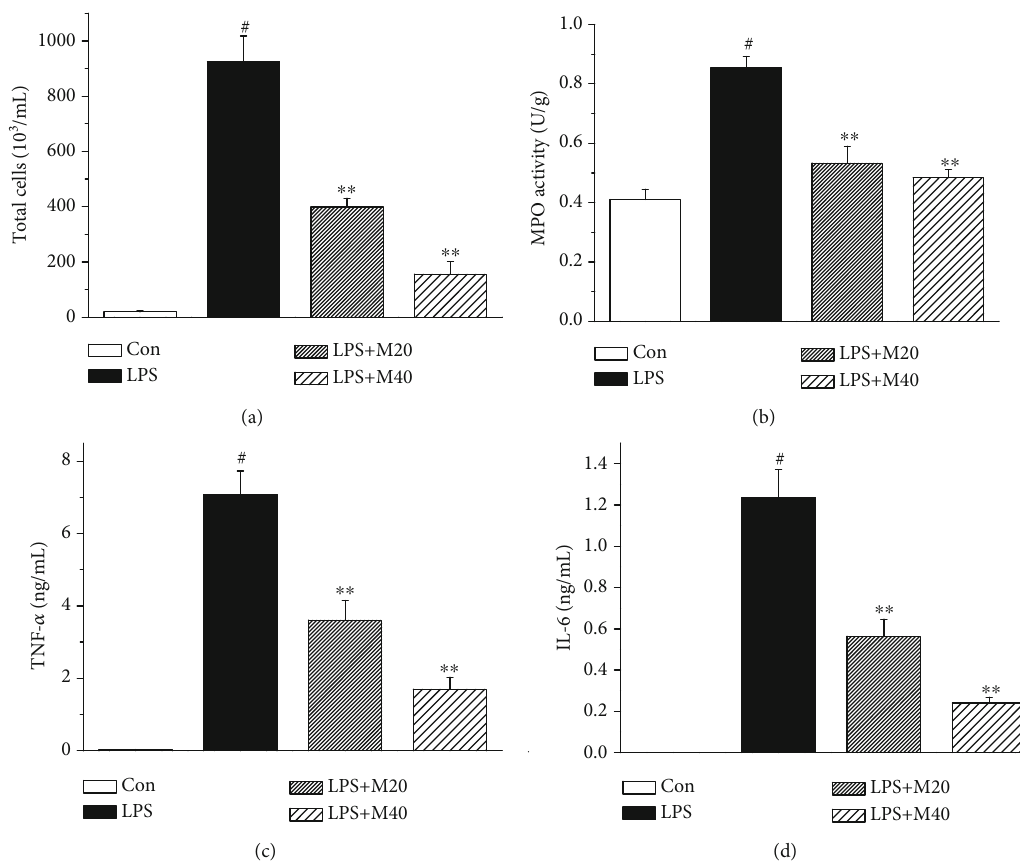
Figure 1: Mibefradil decreased cell counts and in fl ammatory cytokines level in BALF of LPS-induced ALI mice. Mibefradil (20 and 40 mg/kg) was administrated 30min before LPS exposure. Mice were sacri fi ced 6 h after LPS exposure and bronchoalveolar lavage was processed. The total cell number (a), TNF- α (c), and IL-6 (d) levels in BALF were measured. (b) Six hours after LPS exposure, mice were sacri fi ced and the right lung tissues were homogenized with PBS for MPO assay. All values are mean ± SEM ( n = 6 ). # p < 0 : 05 , signi fi cant compared with vehicle-treated control; ∗ p < 0 : 05 , signi fi cant compared with LPS alone; ∗∗ p < 0 : 01 , signi fi cant compared with LPS alone. 0.00.10.20.30.4